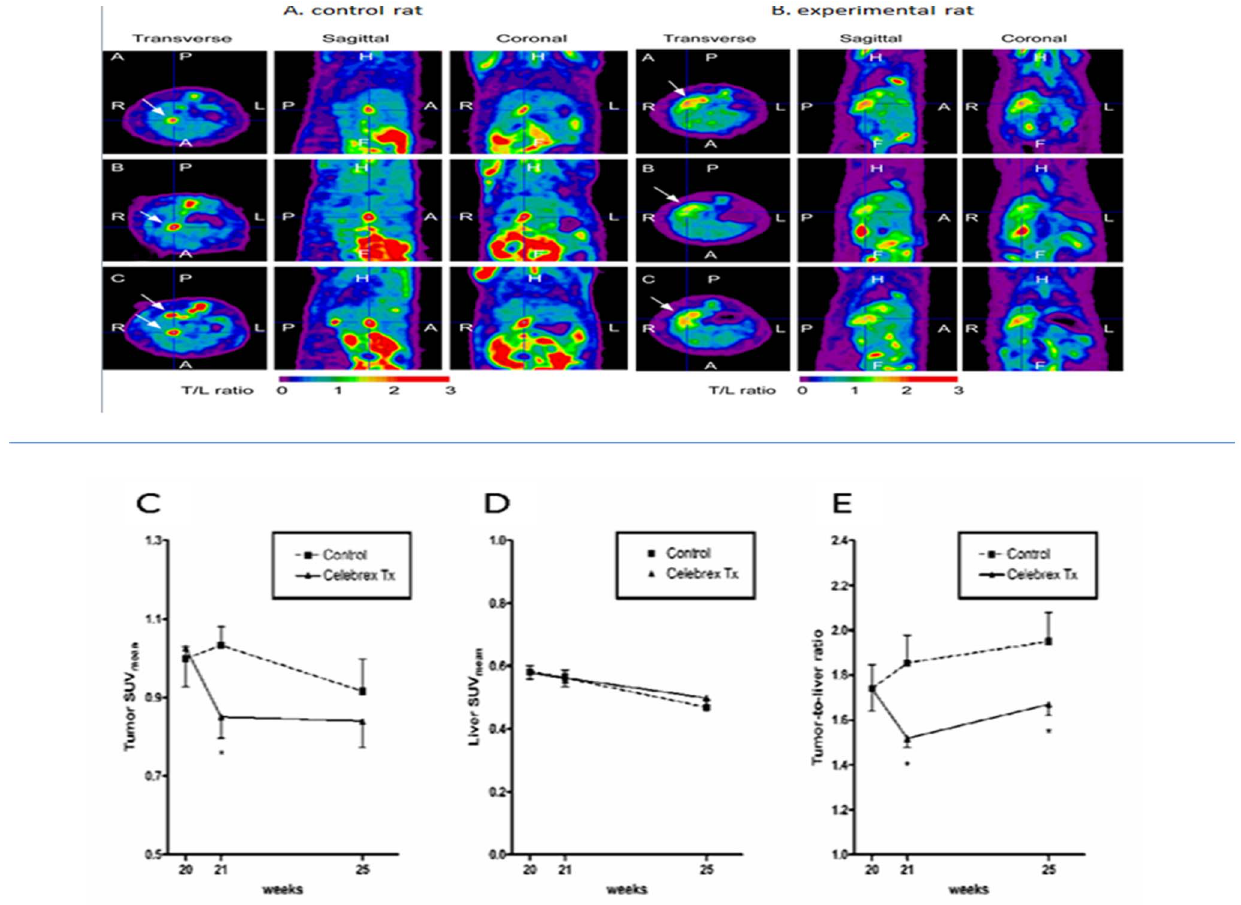
Figure 4. Detection of rat CCA by animal PET and SUV of Tumor, Liver, and Tumor/Liver ratio. (A). Transverse, sagittal, and coronal views of fused CT and PET scans of representing control rats revealed CCA expressing areas of the liver in which the 18 F-FDG uptake was increased from baseline 1 to 5 weeks after the experiment (i.e., weeks 20, 21, and 25). (B) Transverse, sagittal, and coronal views of fused CT and PET scans of representing rats treated with celecoxib revealed CCA expressing areas of the liver in which the 18 F-FDG uptake was slightly increased from baseline1 to 5 weeks after the experiment (i.e., weeks 20, 21, and 25). The arrows indicated the ‘‘hottest point’’ with highest 18 F-FDG uptake. (C) The tumour SUV mean of control rats was initially elevated (week 21) and then decreased to a lower level at the last scan (week 25); however, the tumour SUV mean of rats treated with celecoxib was decreased initially (week 21) and remained at a constant level until the last scan (week 25). (D) The liver SUV mean decreased gradually in control and treated rats during this experiment. (E) The tumour-to-liver (T/L) ratio of SUV showed trend of elevation until the last scans in the control group. In the treatment group, the T/L ratio of SUV was significantly decreased 1 week after celecoxib treatment (control, 1.85 6 0.12; celecoxib, 1.52 6 0.04; p , 0.05).